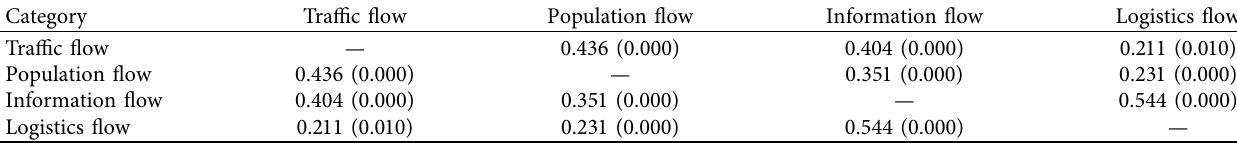
Table 3: Quadratic Assignment Procedure (QAP) of the space of flows.